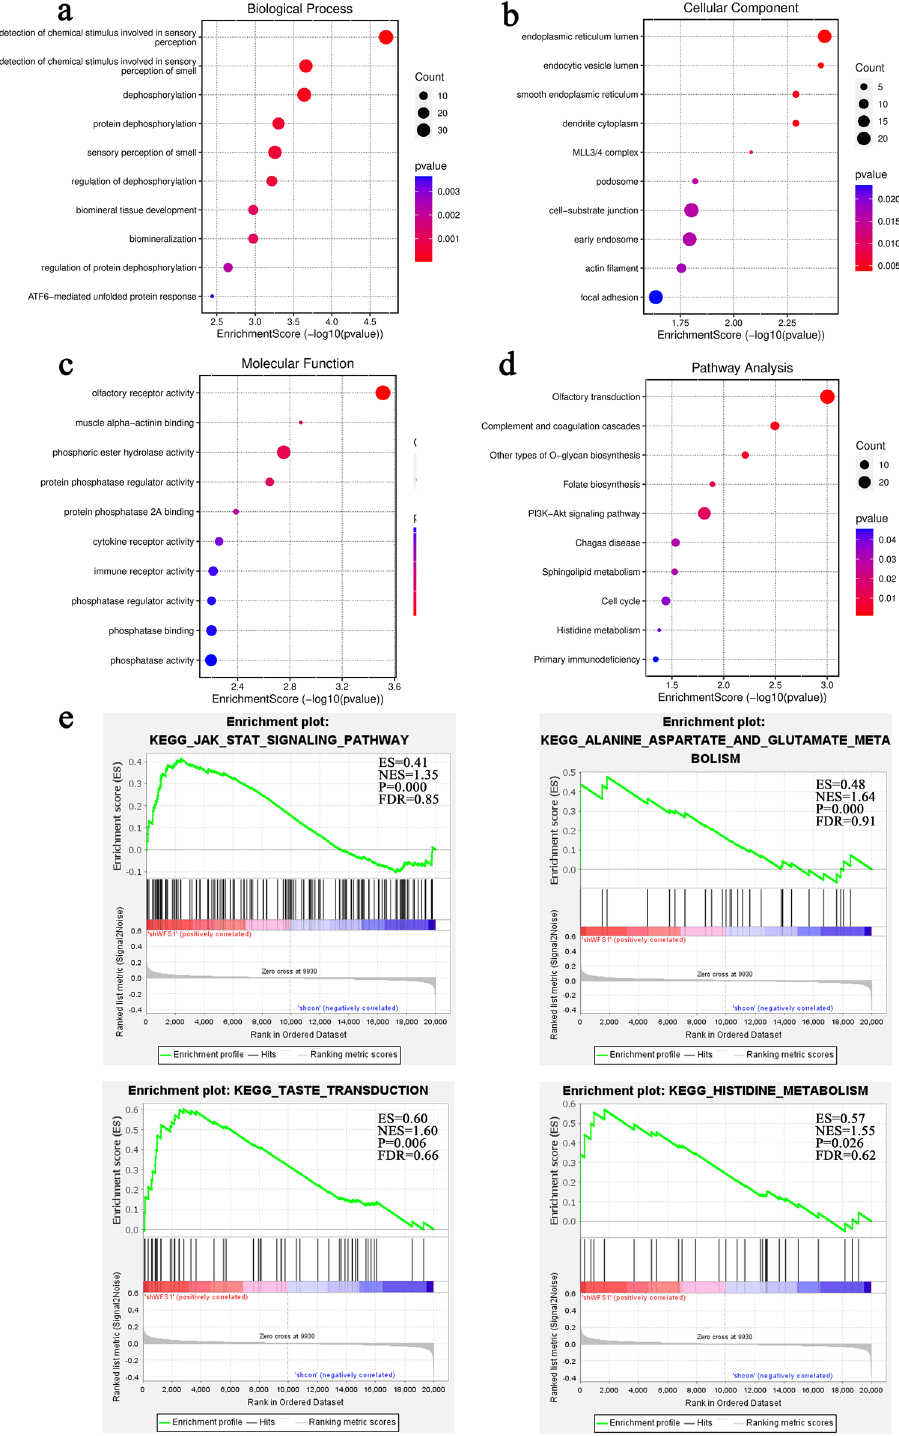
Figure 6. Enrichment analysis between wild type and WFS1 silenced type. ( a ) Biological process of DEGs. ( b ) Cellular component of DEGs. ( c ) Molecular function of DEGs. ( d ) KEGG pathway of DEGs. ( e ) Significant KEGG enrichment plot from GSEA